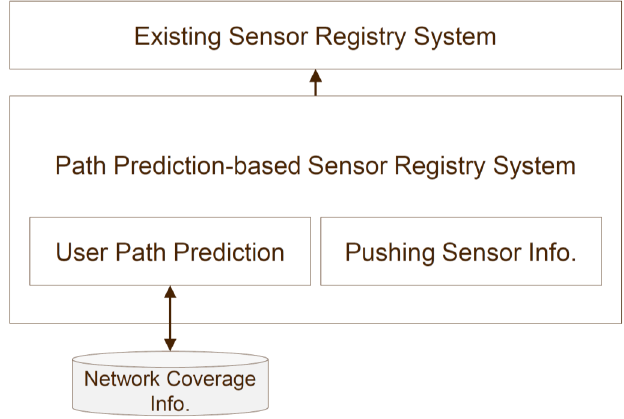
Figure 4. Concept diagram for extending PP-SRS.